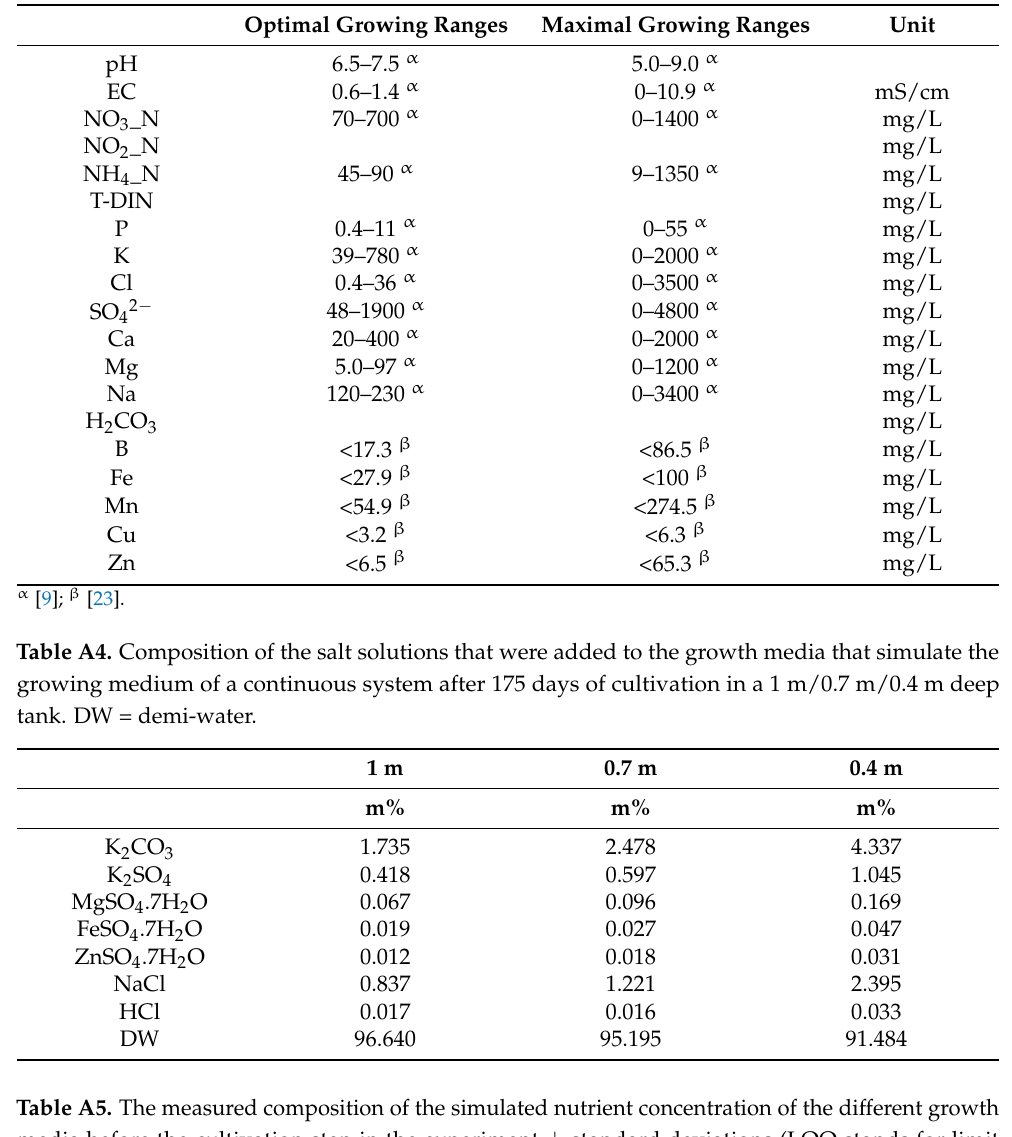
Table A5. The measured composition of the simulated nutrient concentration of the different growth media before the cultivation step in the experiment ± standard deviations (LOQ stands for limit of quantification). ‘Start’ = the composition of the growing medium of a continuous system at the start of the growing season; ‘1 m’/‘0.7 m’/‘0.4 m’ = the composition of the growing medium of